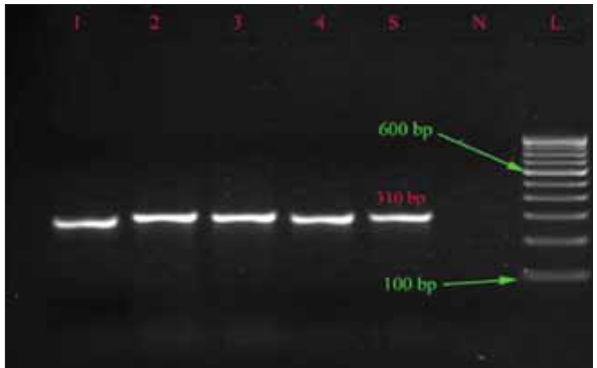
Figure-2: Agarose gel showing polymerase chain reaction amplification products of spv R gene (310 bp).